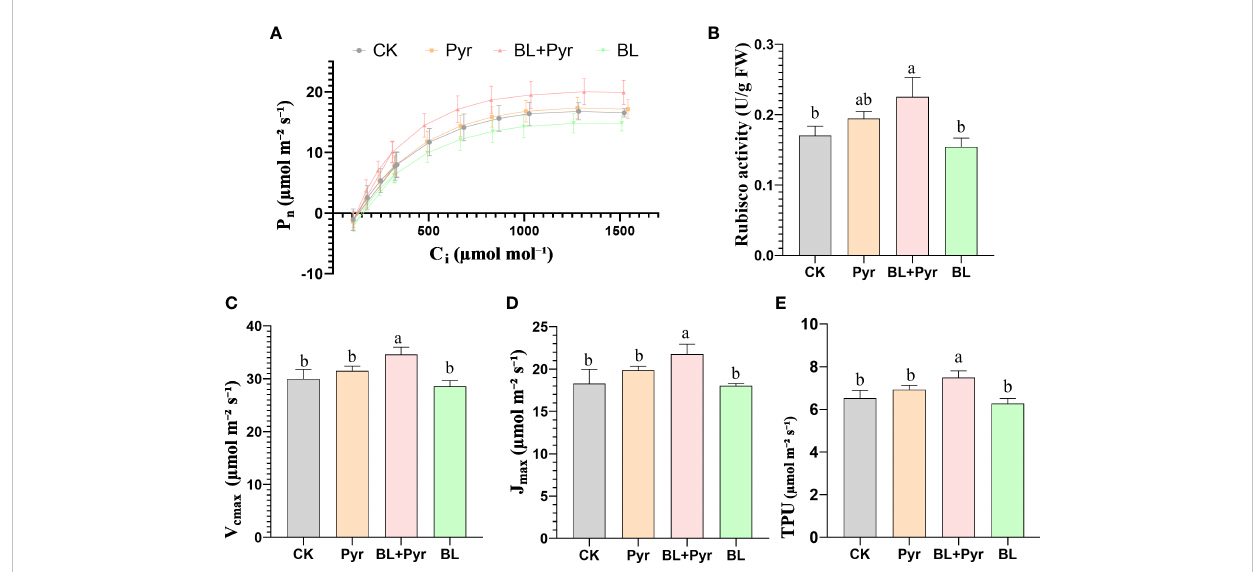
FIGURE 4 BL+Pyr showed a synergistic effect on increasing CO 2 assimilation ef fi ciency. (A) Net photosynthetic rate (P n ) at different CO 2 concentration (400, 300, 200, 100, 400, 400, 600, 800, 1000, 1200, 1500, 1800 μmol mol ⁻ ¹) under saturated light intensity (600 μmol m ⁻ ² s ⁻ ¹); (B) Rubisco enzyme activity (U/g FW); (C) Maximum in-vivo Rubisco carboxylation rates (V c,max ); (D) the maximum rate of electron transport driving regeneration of RuBP (J max ); (E) Maximum rate of photosynthetic product triose-phosphate utilization (V TPU . Data are presented as the mean ± SD (n=3, measured at random in 3 separate replicate experiments). Data are presented as the mean ± SD of three independent replicate experiments. Different letters indicate signi fi cant differences (p< 0.05) according to ANOVA followed by Tukey ’ s test. 31-day-old seedlings (the 11 th day after the fi rst-round application) were used. CK, untreated seedlings; Pyr, seedlings treated with 3 m M pyraclostrobin; BL+Pyr, seedlings treated with 1 m M BL and 3 m M pyraclostrobin; BL, seedlings treated with 1 m M